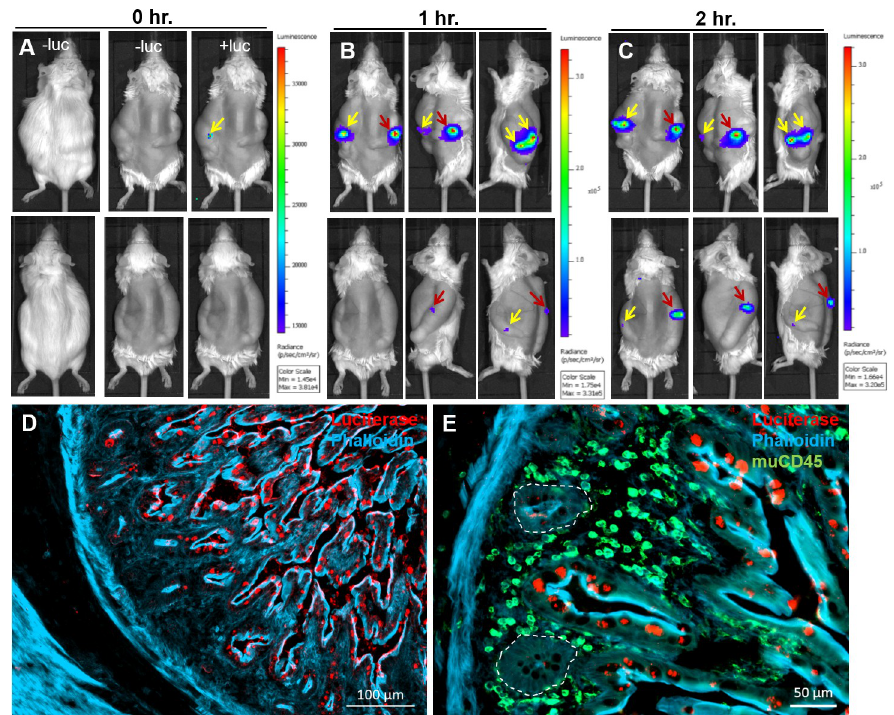
Fig 3. Spatial and temporal activity of NF- κ B in steady state and inflamed human gut activated by systemic human TNF α . Human fetal gut was transplanted into two SCID mice and allowed to develop over 12 weeks. The reporter system and intravital imaging were performed as described above (see Fig 1). Time course of the luminescence activity before activation (A) and 1 (B) and 2 (C) hours after activation following systemic injection of human TNF α are presented. While no luminescence signal was observed before systemic injection of D-luciferin (-luc in A), steady state focal activity was visible in one transplant (yellow arrow in A) after luciferin injection. The focal activity of NF- κ B was discretely activated following systemic injection of TNF α (1 mg/kg) (yellow and red arrows in B-C). The expression of luciferase in the human gut transplant 2 hours after activation with TNF α was imaged using immunostaining and fluorescence microscopy (D-E). Representative images of fluorescence staining of cryosections using phalloidin (D-E, blue), anti luciferase antibodies (D-E, red) and anti murine CD45 antibodies (green in E). Luciferase expression is limited to mucosal villous epithelial cells (crypts are demarcated by broken white line E). Scale bars, 100 μ m (D) and 50 μ m (E). Representative results of one experiment out of five similar experiments.